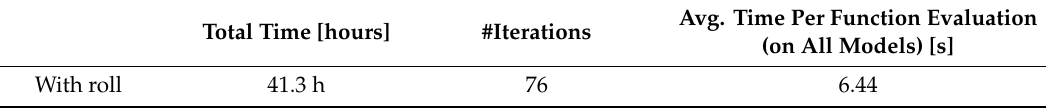
Table 6. Optimization procedure details.